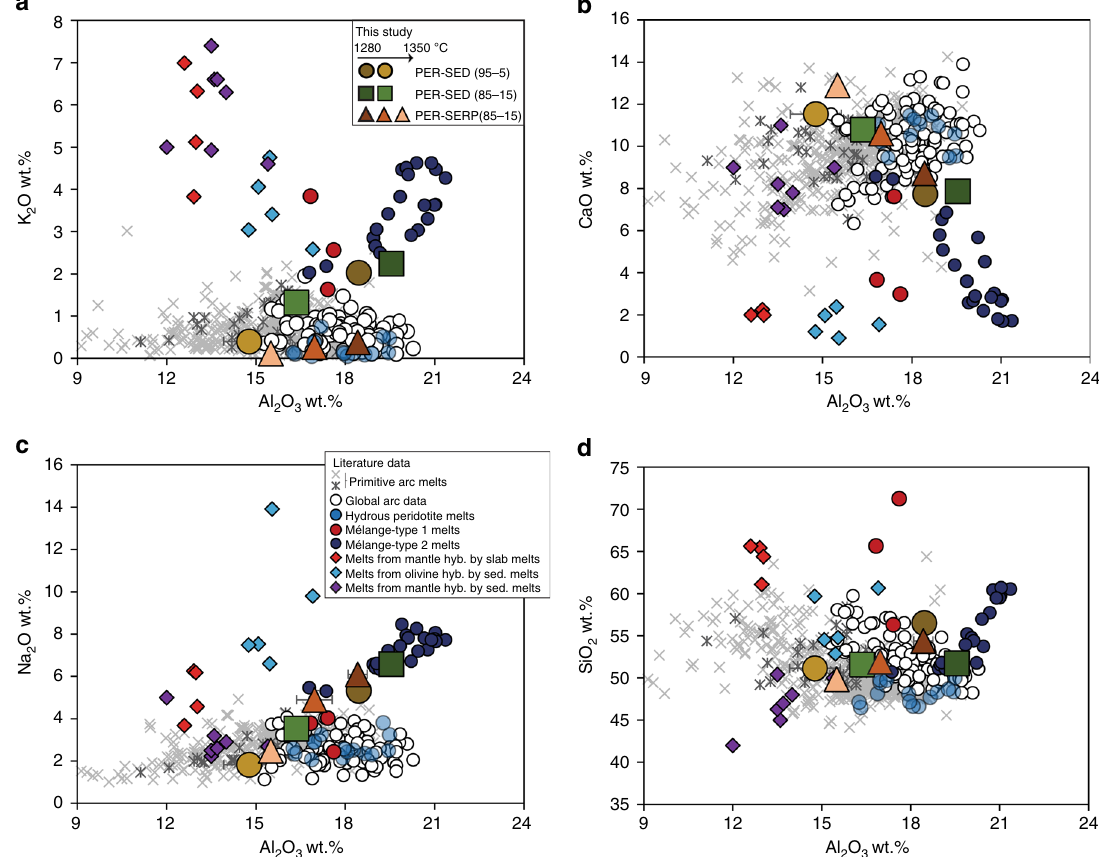
Fig. 4 Major element composition of experimental melts. Major element variations a K 2 O, b CaO, c Na 2 O, d SiO 2 vs Al 2 O 3 of experimental peridotite- mélange melts from this study compared to global arcs 35 (normalized to MgO = 6 wt.%), two primitive arc melts compilations, and previous experimental studies 37,38,41 . The two primitive arc melts compilations are from Schmidt and Jagoutz 33 (gray asterisk) and Till et al. 34 (light gray cross). Hydrous peridotite melts are from Gaetani and Grove 36 . Experimental melts from mantle hybridized by slab melts and sediment melts are from Rapp et al. 37 and Mallik et al. 41 , respectively. Experimental melts of olivine hybridized by sediment melts are from Pirard and Hermann 38 . Experimental mélange-type 1 melts are from Castro and Gerya 27 and Castro et al. 39 , while the experimental mélange-type 2 melts are from Cruz-Uribe et al. 40 Our experiments are plotted as averages with error bars representing 1 s.d. All the data, including the literature, are plotted on volatile-free